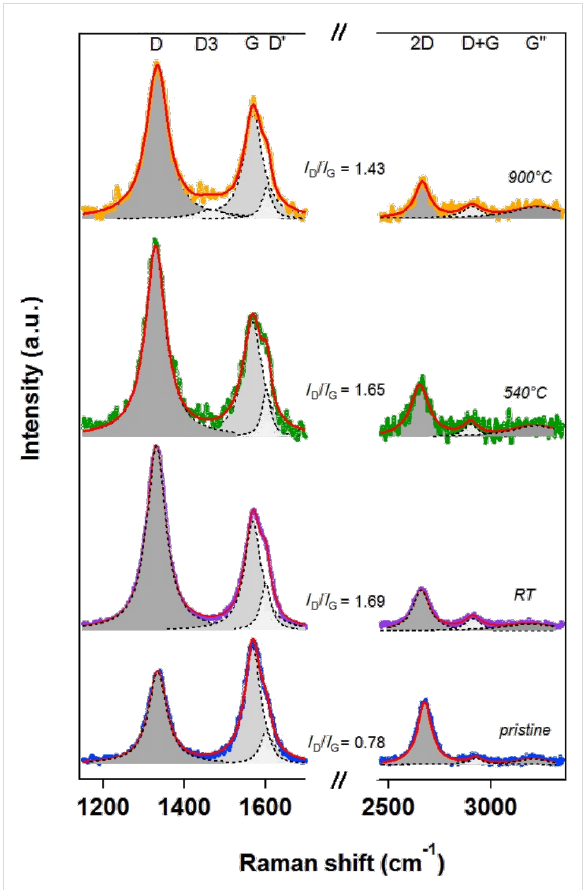
Figure 4: Raman spectra acquired on pristine, functionalized and ther- mally treated vCNTs. The spectrum at the top was recorded after heating the sample to T = 900 °C, which corresponds to a completely defluorinated sample. The spectra were normalized to the G-peak